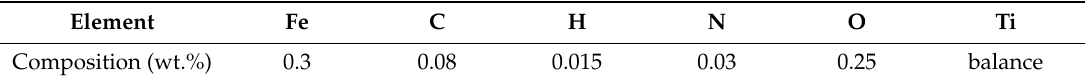
Table 1. The chemical composition (wt.%) of the titanium plate. Element Fe C H N O Ti Composition